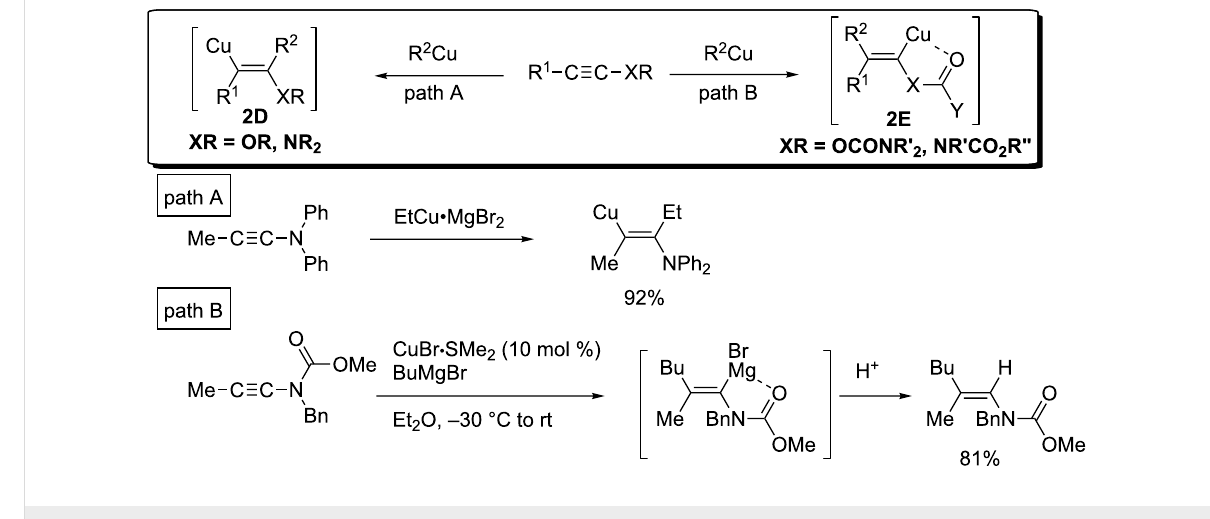
Scheme 13: Controlling regioselectivity of carbocupration by attaching directing groups.